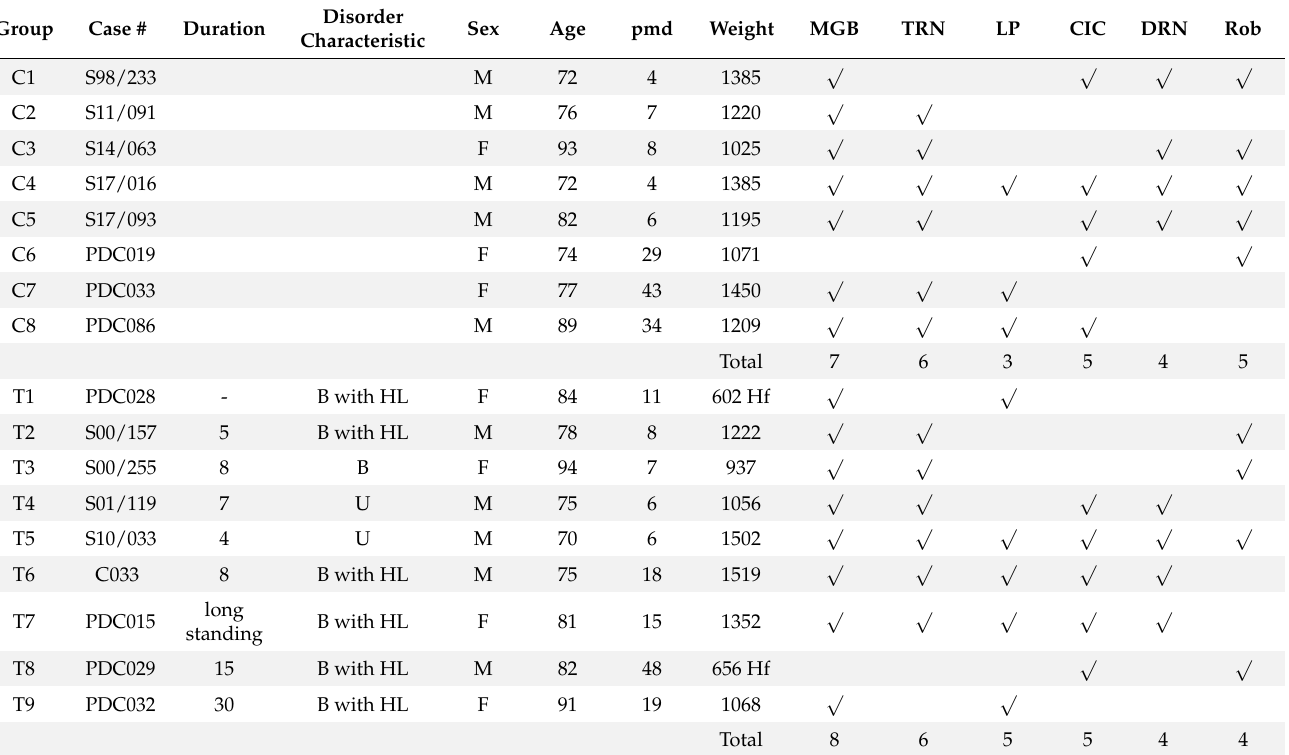
Table 1. Specifications of control (C1–C8) and tinnitus (T1–T9) tissue